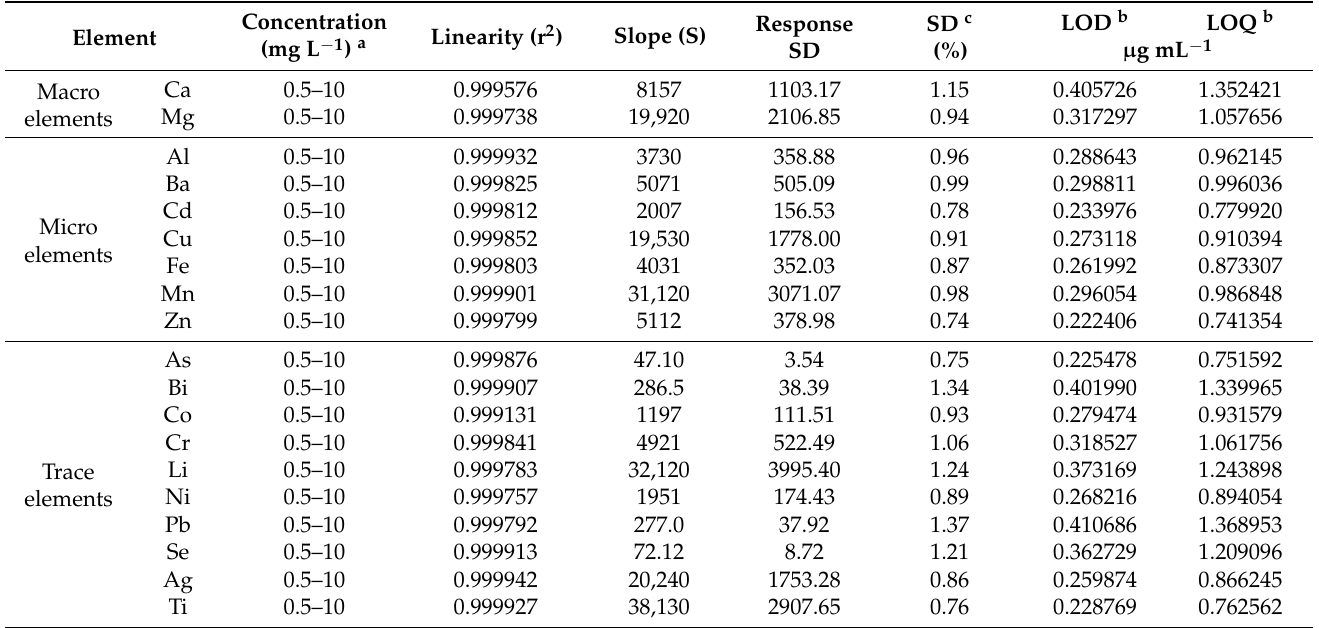
Table 3. Calibration curves, limit of detection (LOD), and limit of quantitation (LOQ) of the 19 elements examined in this study.